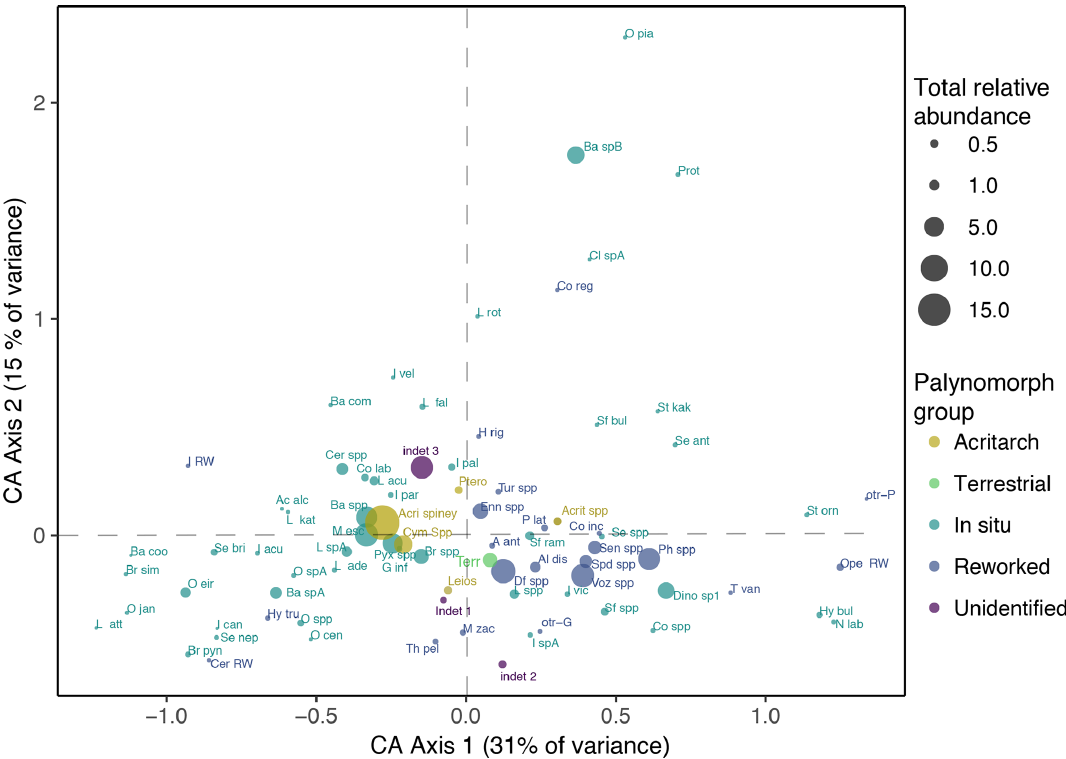
Figure 3. Correspondence analysis (CA) of the dinocyst assemblage data from DSDP Site 274. The size of the points indicates the total relative abundance of the specific species. The abbreviations of the dinocysts species can be found in Table 1. The data were plotted in the C2 software program (Juggins, 2007). The analysis scores are provided in Table